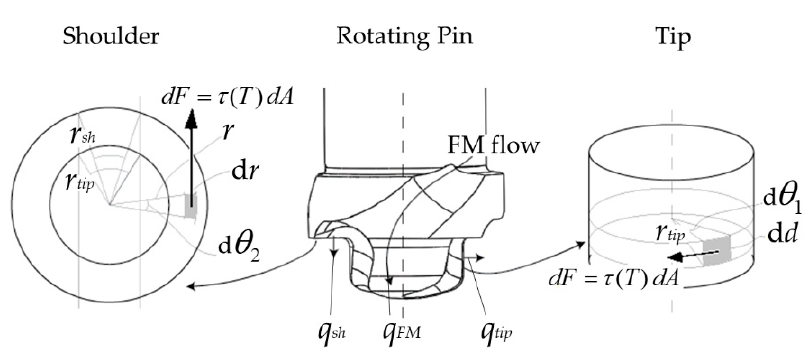
Figure 3. Schematic drawings of the rotating pin with its protruding cylindrical tip and flat shoulder. As an aid to the reader, some of the symbols and parameters used in deriving the mathematical expressions for the net heat generation are also highlighted.